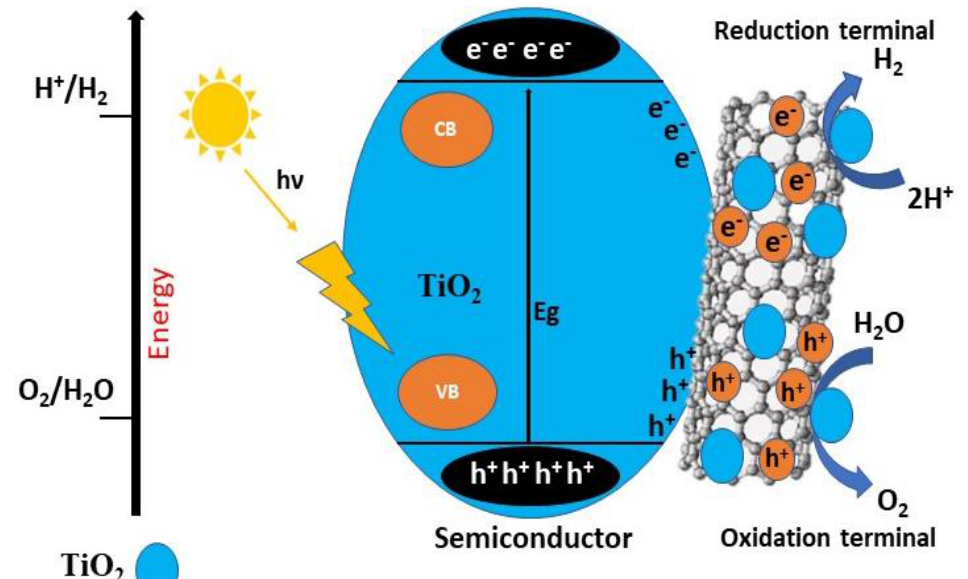
Figure 3. The CNTs/TiO 2 composite for hydrogen production.